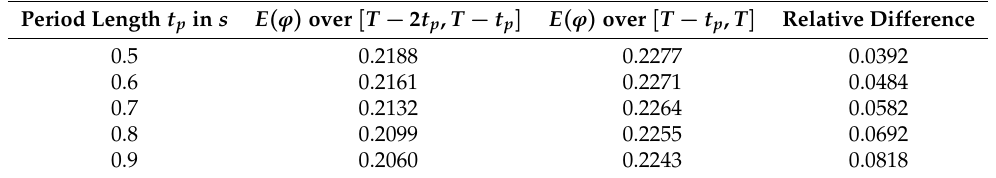
Table 1. Average concentration E ( ϕ ) over the two last time periods of length t p and relative difference between these values, for varying of t p